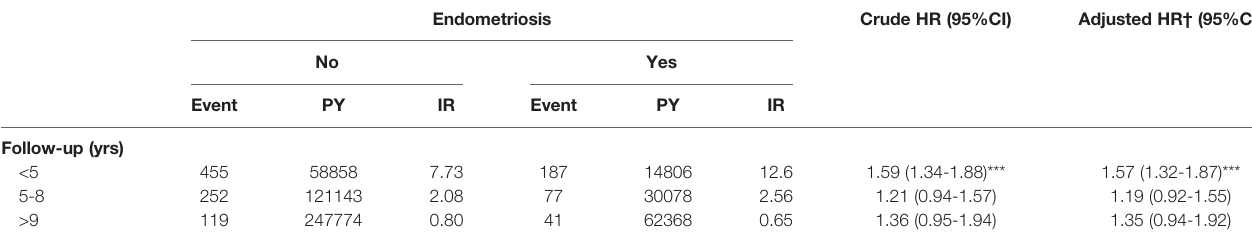
TABLE 4 | Cox regression analyses of Sjögren ’ s syndrome in patients with endometriosis strati fi ed by follow-up